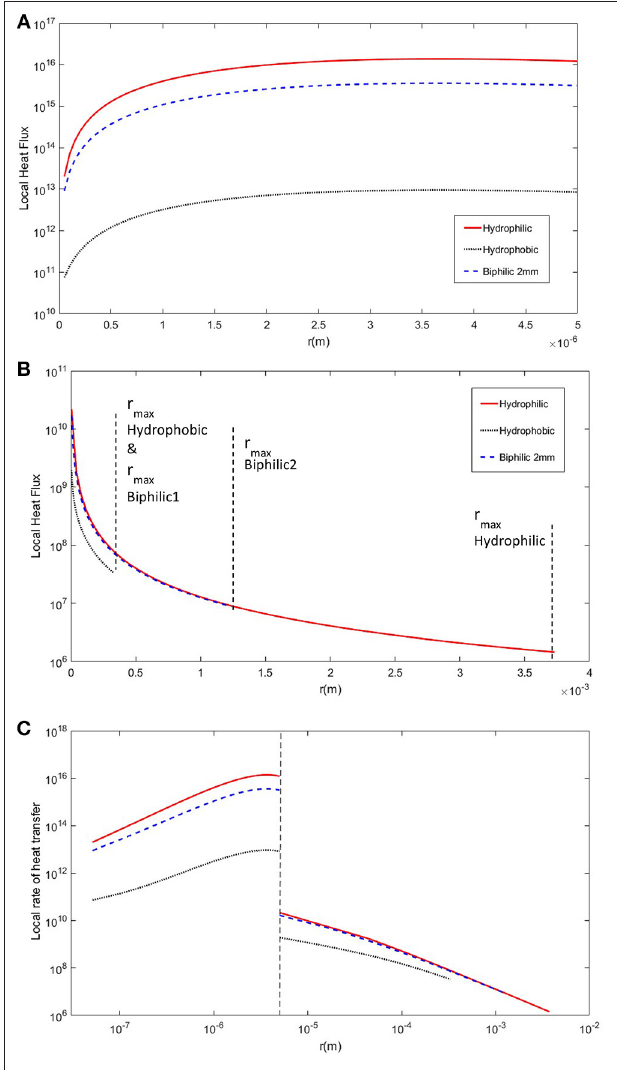
FIGURE 4 | The steady-state single droplet condensation heat flux as a function of droplet radius for hydrophilic, hydrophobic, and 2mm biphilic substrates. (A) The heat flux is shown for small droplets formed by direct condensation. (B) The heat flux is shown for large droplets formed by coalescence. The fall-off radii are shown for each substrate. The biphilic surface has two separate fall-off radii corresponding to the hydrophobic sites and hydrophilic base marked as biphilic1 and biphilic2, respectively. (C) The log-log graph of combined heat flux for all droplets from initial nucleation to fall-off. The dashed line shows the borderline between small droplets and large droplets. The associated model parameters are: T sat 20 ◦ C, T w 10 ◦ C, = = − δ coat 1 µ m, k coat 0.15 W/m.K, γ 2mm, hydrophobic θ a and θ r are = = = 150 ◦ and 144 ◦ , and hydrophilic θ a and θ r are 73 ◦ and 34 ◦ .